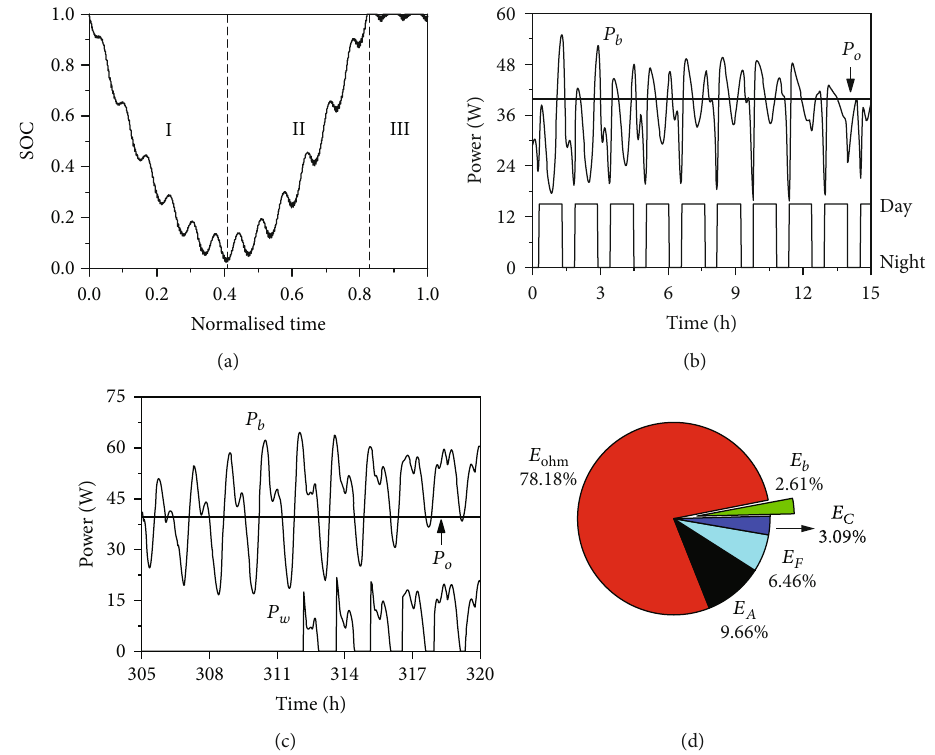
Figure 8: Dynamic behaviour of the battery system at maximum power consumption. The mission time is about 359 h: (a) SOC v. mission time; (b) power change from time 0 h to 15 h; (c) power change from time 305h to 320h; (d) energy ratio